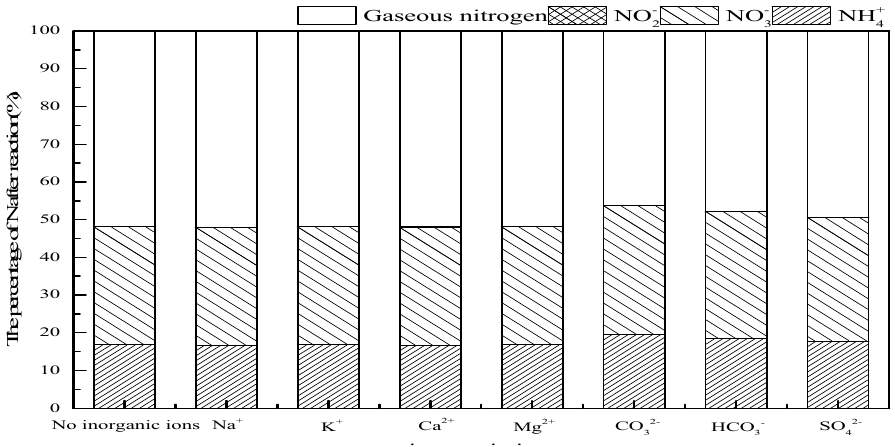
Figure 10. E ff ect of inorganic ions on ammonia conversion in SrO-Al 2 O 3 / US / O 3 system. Reaction Figure 10. Effect of inorganic ions on ammonia conversion in SrO-Al 2 O 3 /US/O 3 system. Reaction conditions: initial NH 4 + concentration 50 mg / L, initial pH 9.5, ozone flow 0.8 g / h, catalytic dosage conditions: initial NH 4+ concentration 50 mg/L, initial pH 9.5, ozone flow 0.8 g/h, catalytic dosage 2.0